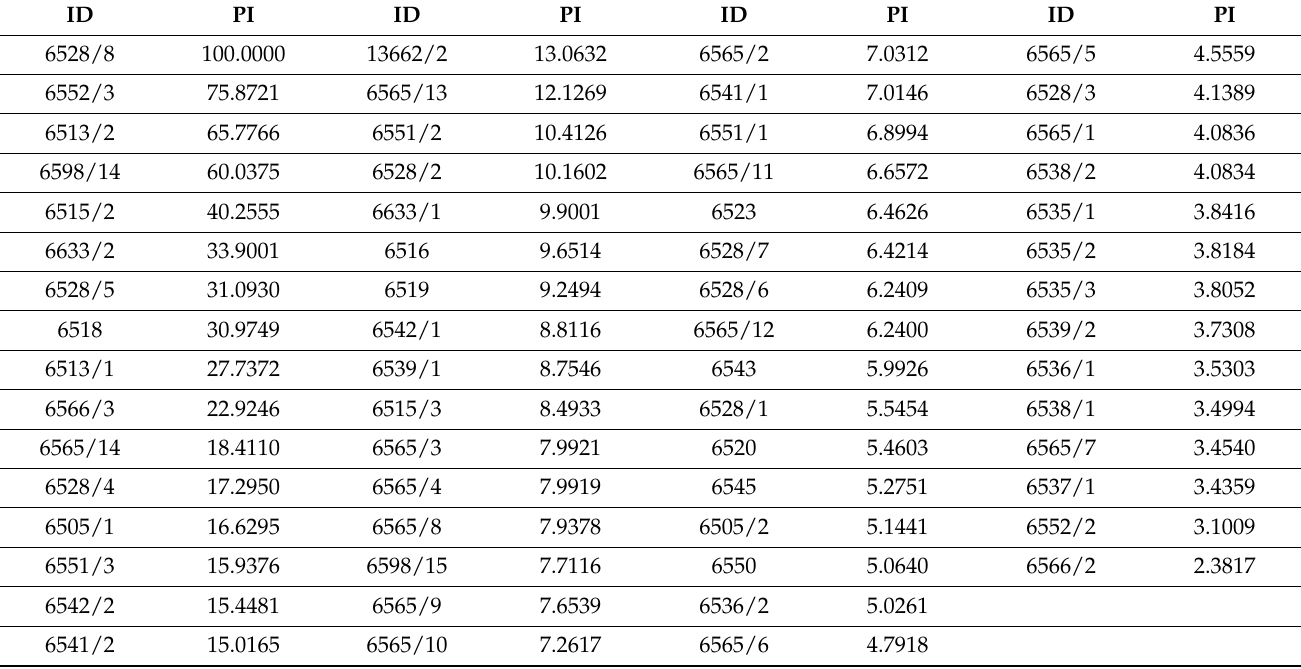
Table 8. Performance Index (Pi) for cadastral